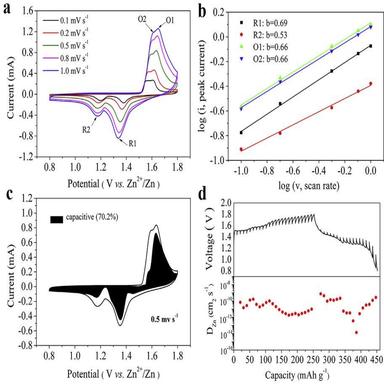
(a) The CV curves of ZnMn2O4/NG at different scan rates, (b) log(i)-log(v) plots for specific peak current, (c) capacitive contribution at 0.5 mV s−1 , and (d) GITT curve and calculated Zn2+ diffusion coefficient of ZnMn2O4/NG electrode during the 21st cycle.